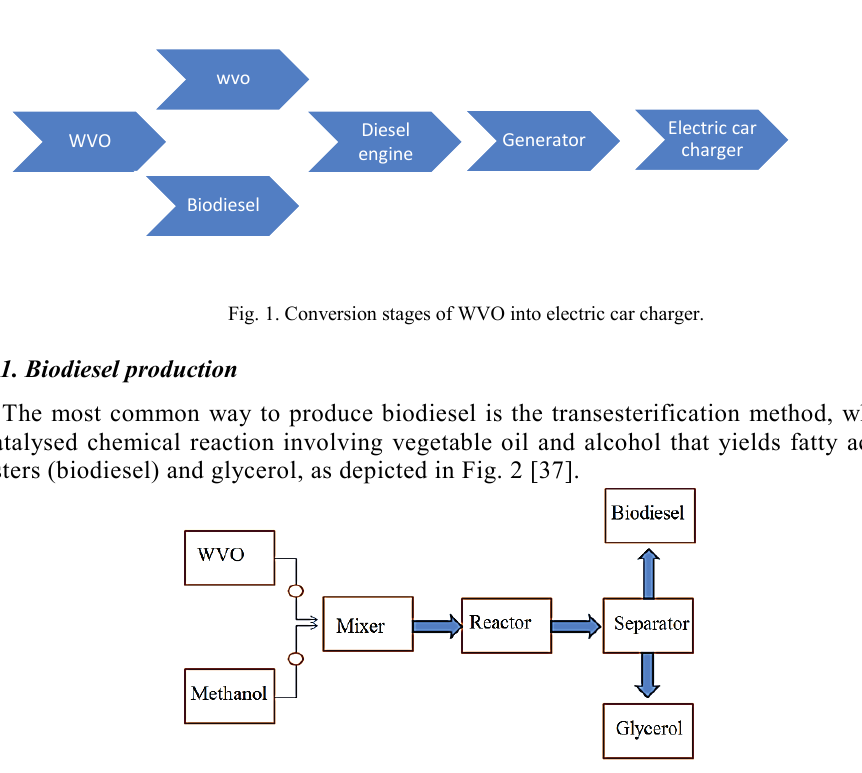
Fig. 2. Biodiesel production